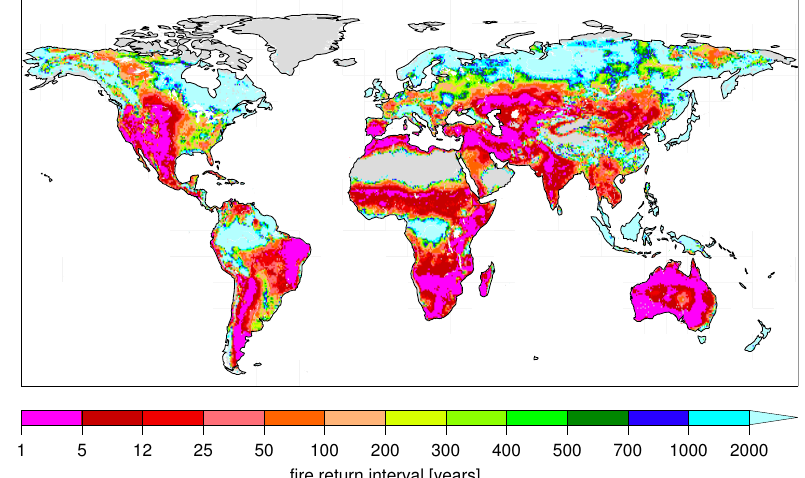
Fig. 11. Simulated global fire return intervals for a model run over a time period of 1000yr using the detrended 20th century reanalysis and LIS/OTD-derived lightning